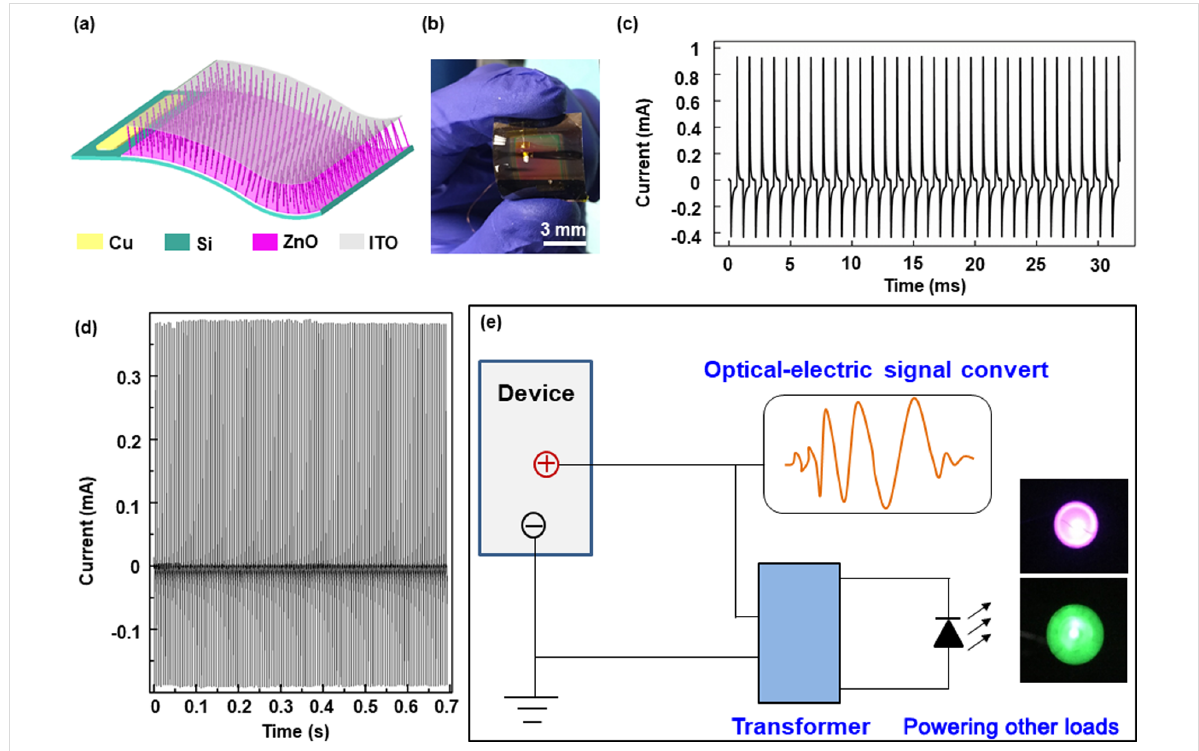
Figure 5: (a) Structure diagram of an ultra-thin (45 μ m) p-Si/n-ZnO heterojunction device. (b) Optical image of the flexible PD. (c) Short-circuit photoresponse current of the ultra-thin (45 μ m) p-Si/n-ZnO heterojunction device under zero bias by periodically turning on/off 325 nm UV illumination with a frequency of 1 kHz. (d) Dynamic response characteristics under 1064 nm NIR illumination. (e) Schematic diagram of a PENG powering differ- ent loads.